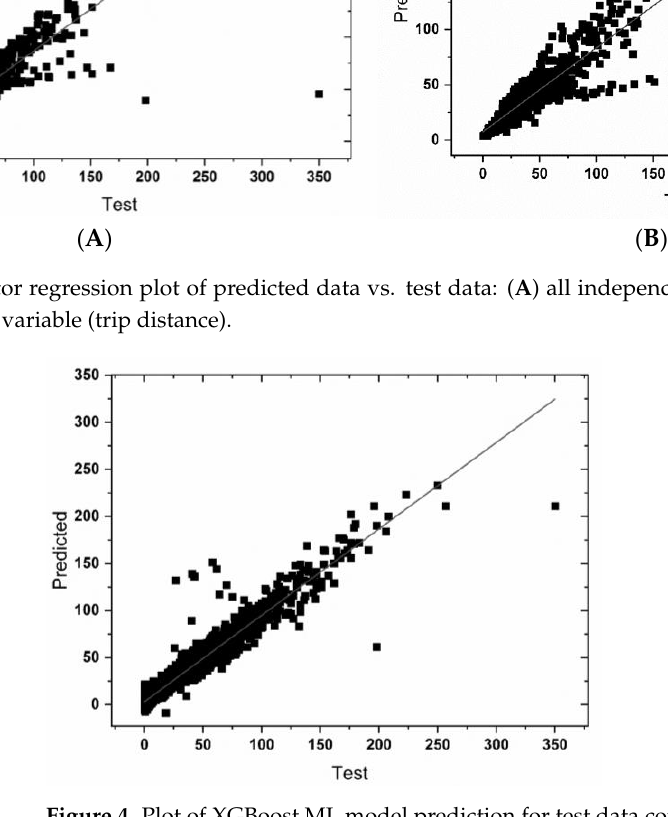
Figure 4. Plot of XGBoost ML model prediction for test data compared with the actual values.